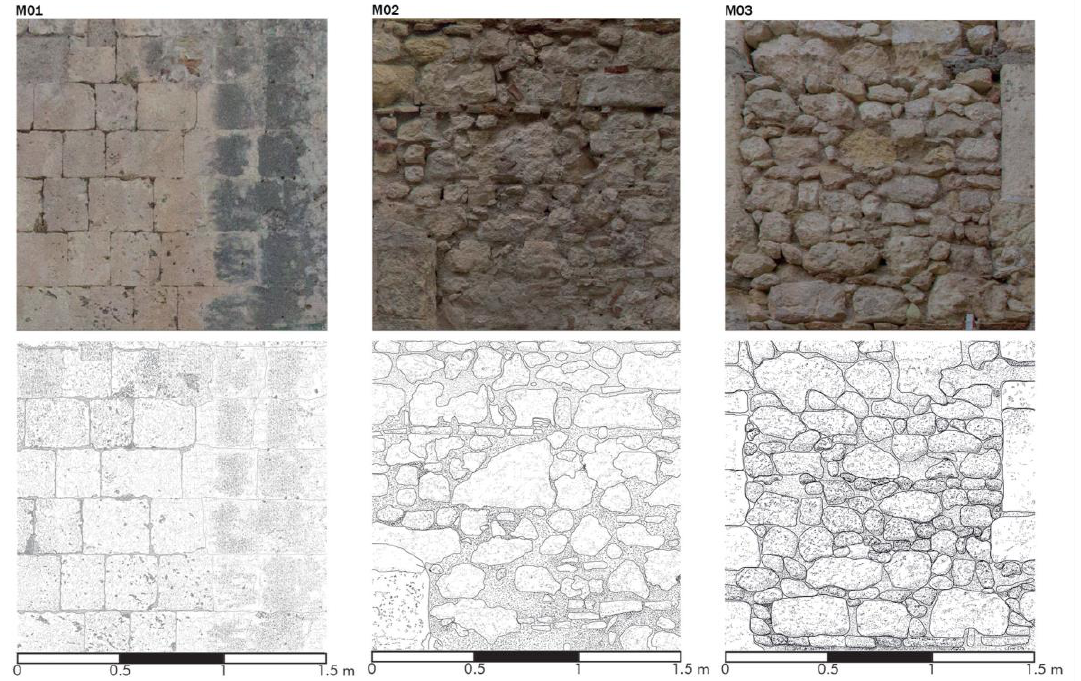
Figure 7. Masonry typologies (the analysis of building techniques has been carried out in collaboration with the Masterclass in Architectural Restoration a.a.2017-2018, Fiorino D.R., tutor Pilia E., (graphic elaboration: Loi M., Pinna M., Mura